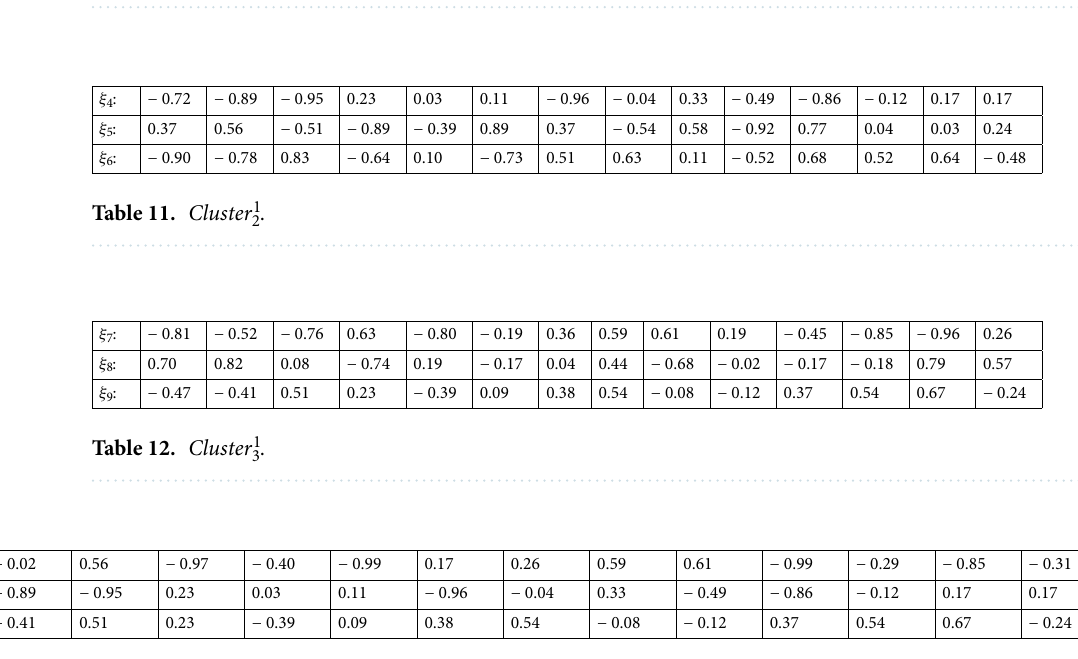
Table 13. Local best population. ( ξ